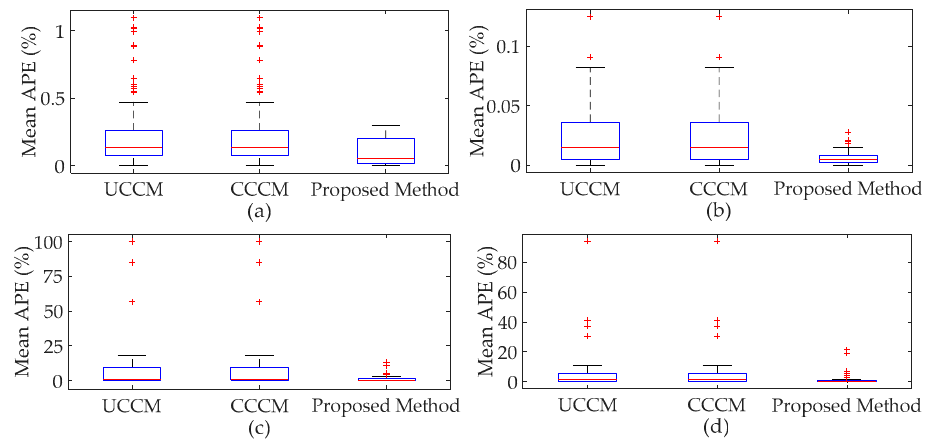
Figure 7. Box plot of mean APE of results (modified IEEE 118-bus test system). ( a ) Voltage angle; ( b ) Voltage magnitude; ( c ) Active power generation; ( d ) Reactive power generation. Energies 2017 , 10 , 1623 14 of 20